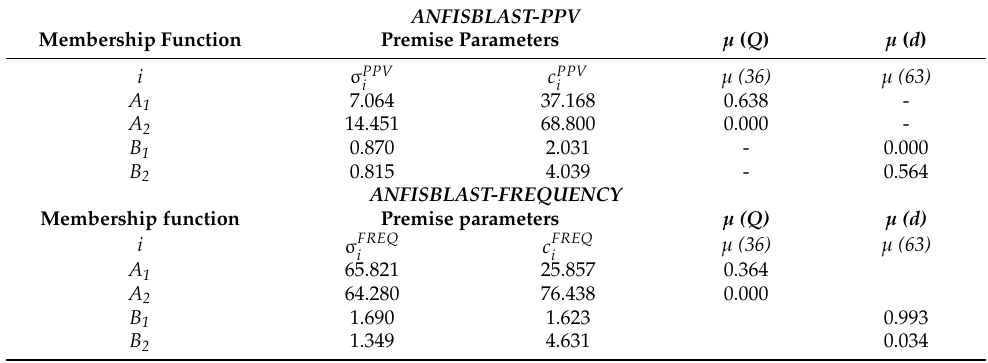
Table 10. Premise parameters of the Gaussian membership function for the ANFIS models PPV and FREQUENCY .